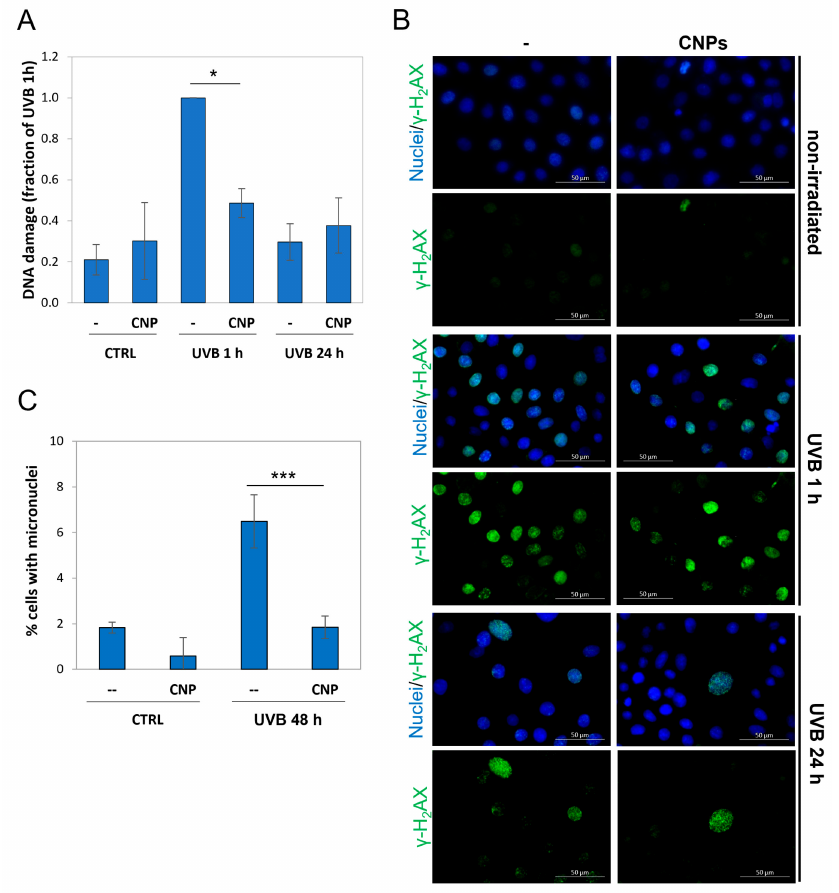
Figure 6. Nanoceria reduces DNA damage and prevent mutagenesis in primary human keratinocytes. ( A ) Comet assay of primary keratinocytes (KC 5993) ± nanoceria (CNPs) at 1 h or 24 h after UVB exposure. Values are normalized with respect to the maximum value (UVB 1h) posed = 1. Statistical significance was calculated via Student’s t -test. * p < 0.05. ( B ) Immunofluorescence with anti- ± nanoceria (CNPs) at 1 h or 24 h after UVB γ -H 2 AX antibody and DAPI staining of KC 5993 exposure in wide-field micrography. The scale bar corresponds to 50 µ m. ( C ) Percentage of cells containing micronuclei among binucleated KC 5993 cells 48 h after UVB irradiation ± nanoceria (CNPs). Statistical significance was calculated via Student’s t -test. *** p <